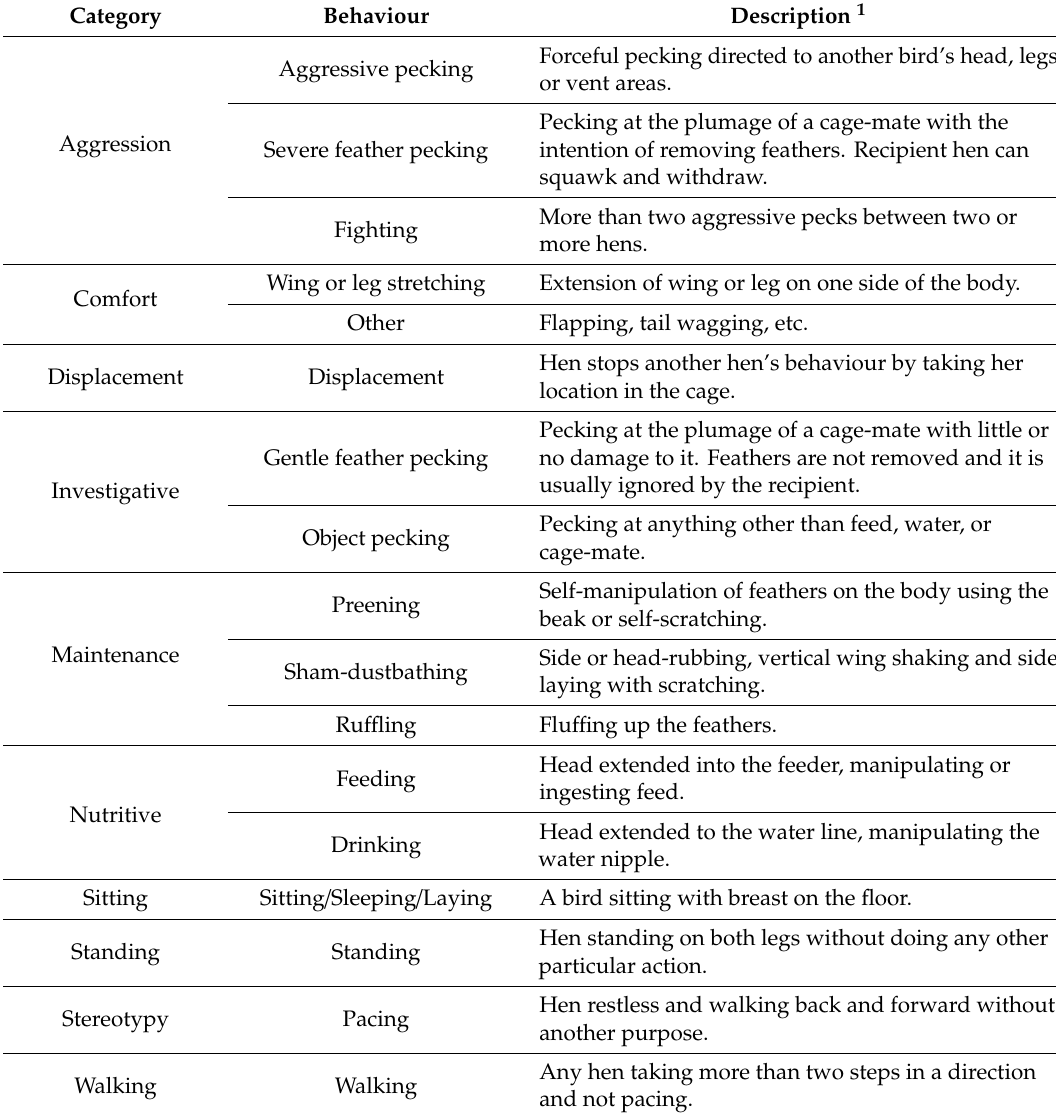
Table 2. Behavioral scan observations